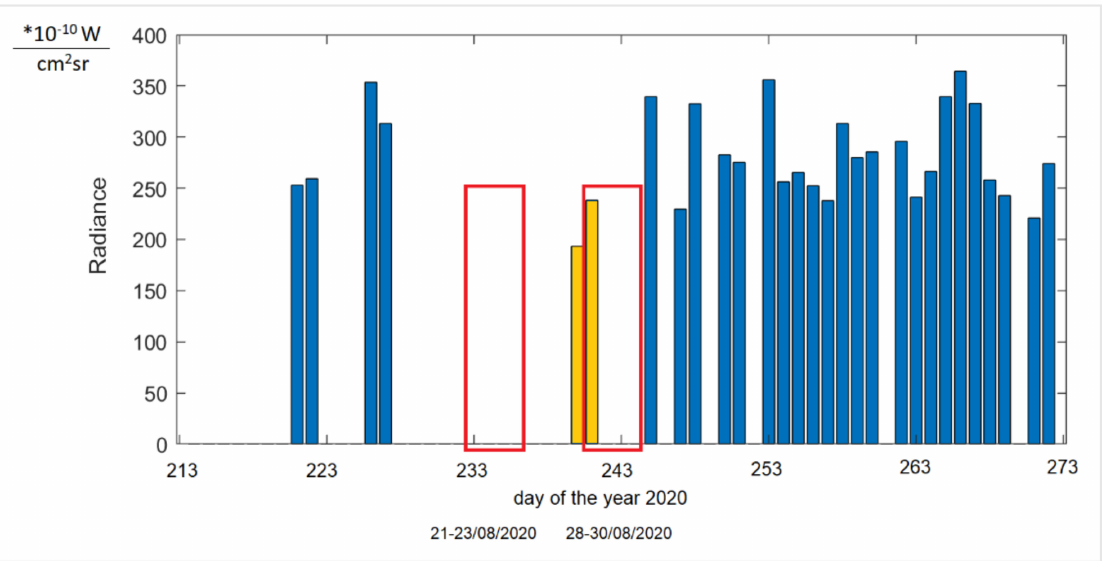
Figure 17. Radiance levels at night from registration August–September 2020 for the area of the Wisłouj´scie Fortress. (The red rectangles were used to mark the period in which the festival took place. The colour yellow indicates the availability of high-quality data which could be used for the analysis. The blue colour indicates availability of high-quality data, except on festival nights. Zero values for individual days mean that the data recorded for that area were either unavailable or of poor quality). * Unit of radiance.